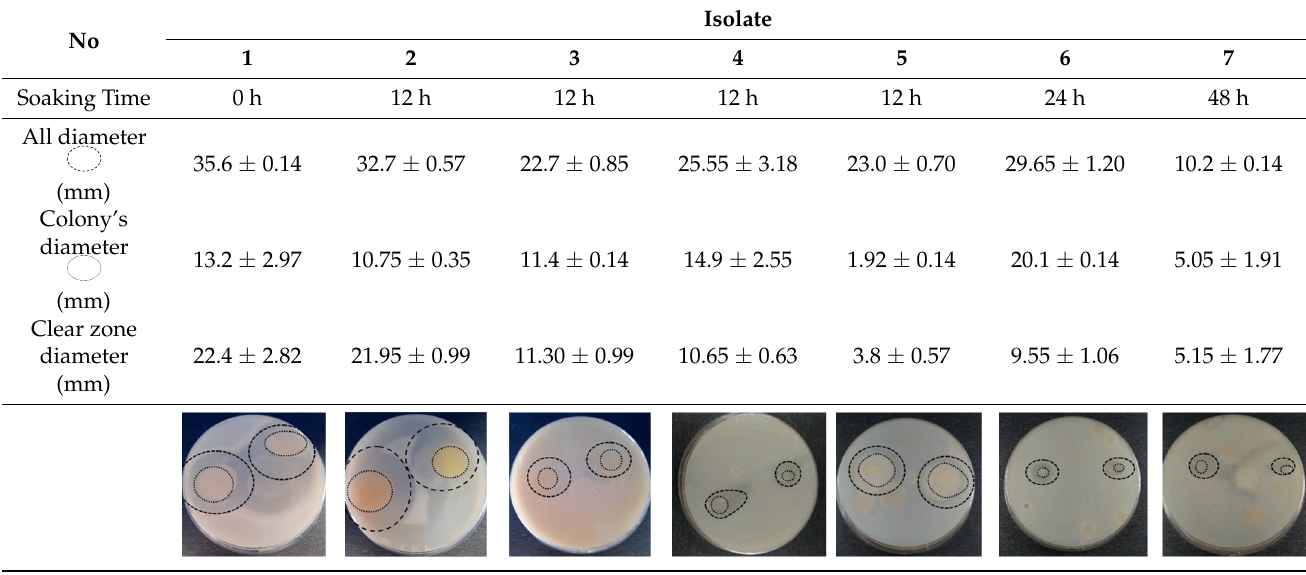
Table 2. The Qualitative Proteolytic Assay by Clear Zone (mm).